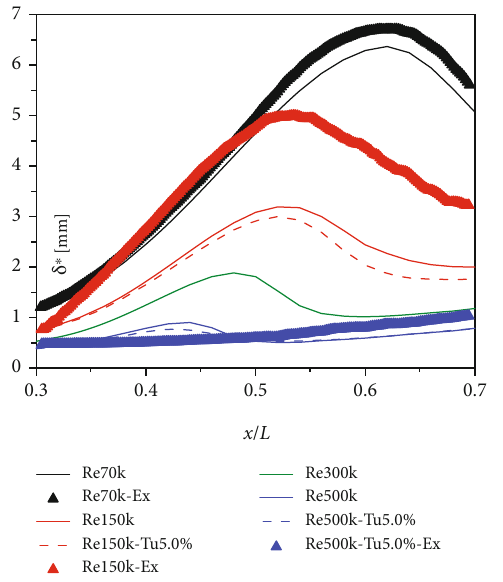
Figure 13: Displacement thickness comparison ( Tu = 1 : 5 %).